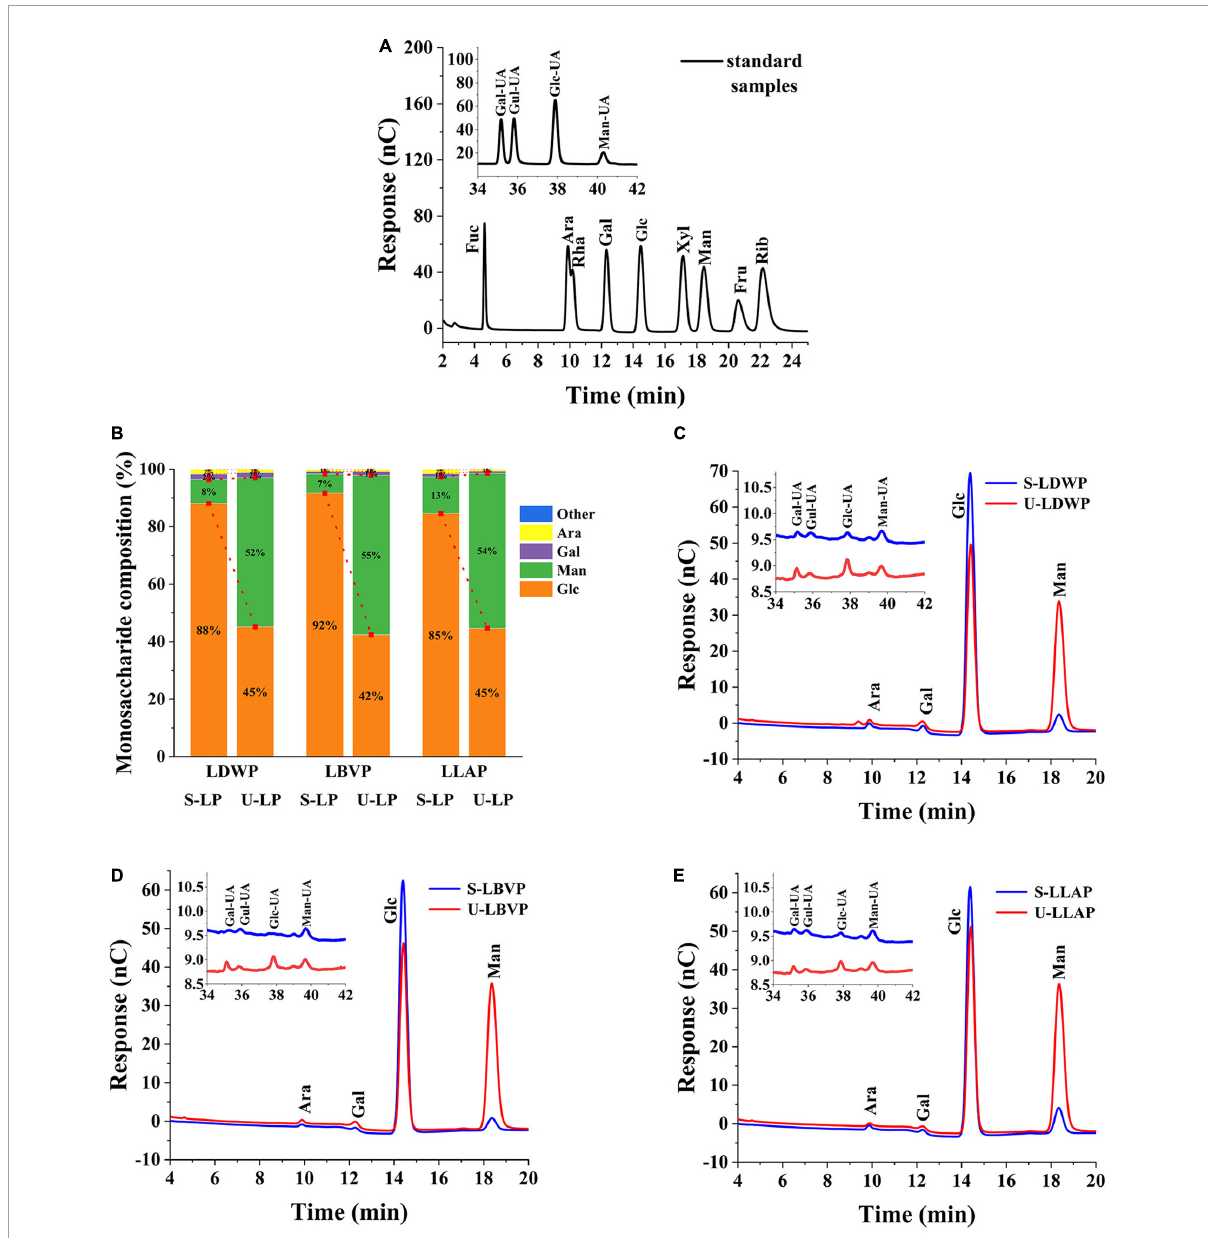
FIGURE2 Diagram of HPAEC results. (A) Standard sample. (B) Monosaccharide ratio of all samples. (C) Lilium davidii var. willmottiae polysaccharides (LDWP) sample. (D) Lilium brownii var. viridulum polysaccharides (LBVP) sample. (E) Lilium lancifolium polysaccharides (LLAP)